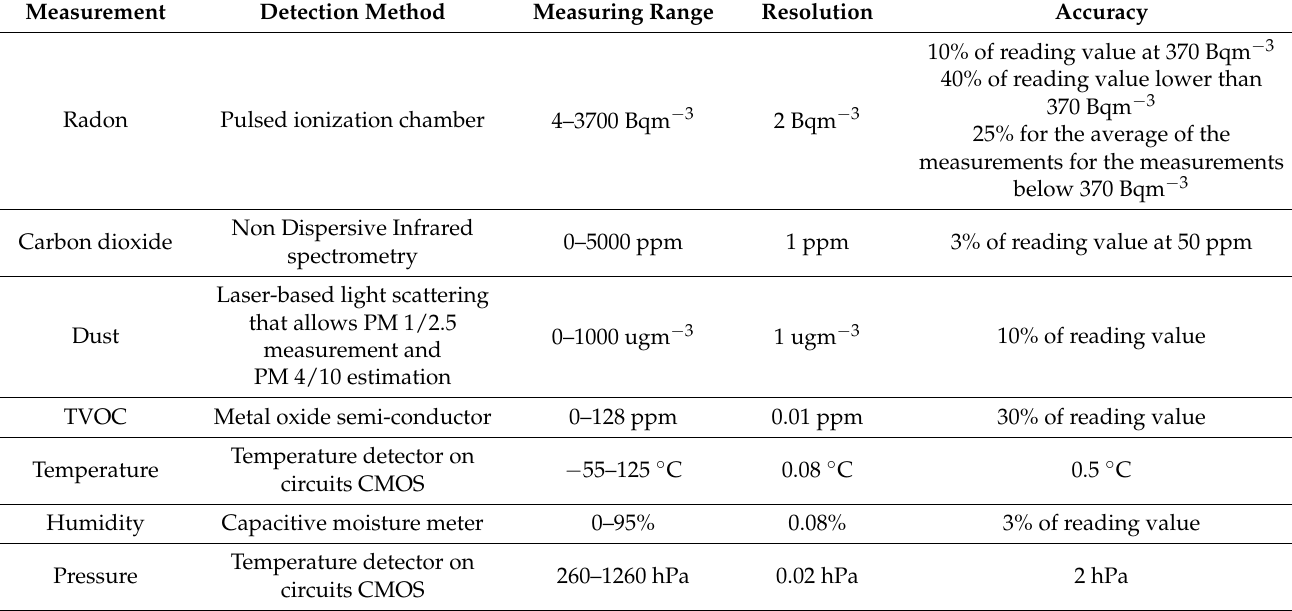
Table 3. Characteristics of the measuring devices